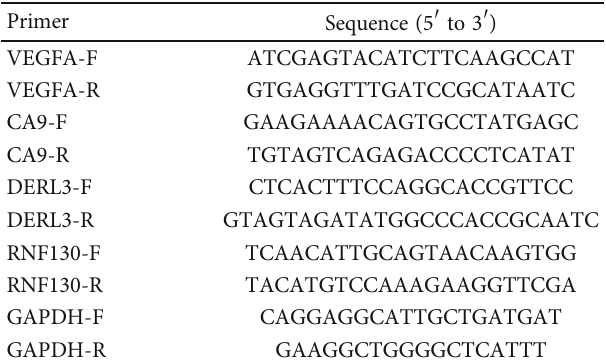
Table 1: Forward and reverse sequences of primers for VEGFA, CA9, DERL3, RNF130, and